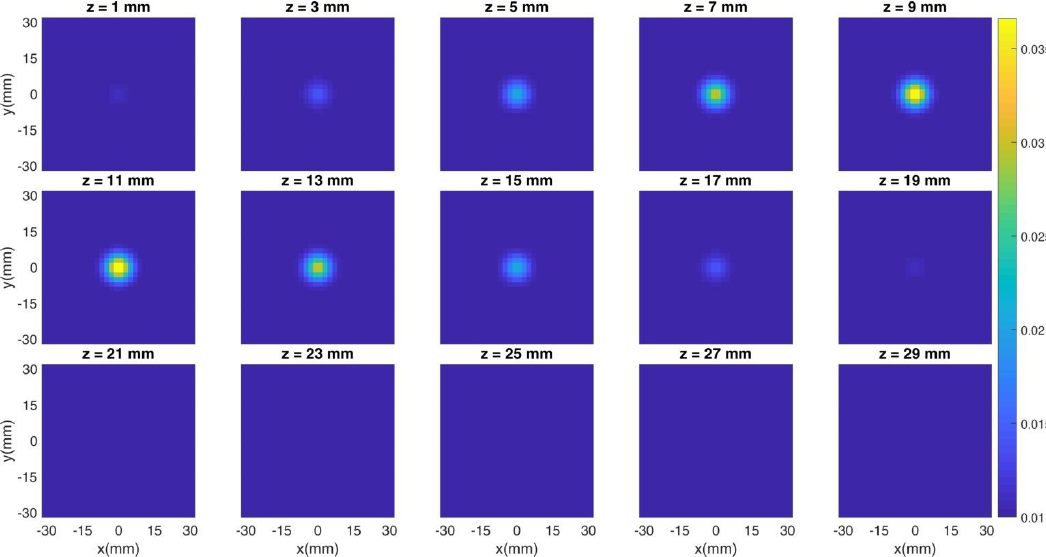
Figure 7. Map of the CNR on the absorption coefficient. Horizontal axis of each subplot is the simulated x position of the inclusion and vertical axis is the simulated y position. Rows are for different z coordinates of the inclusion while the columns for different 𝜏 . Colors show a range from 1 (blue) to 37 (red), that is the maximum CNR obtained.